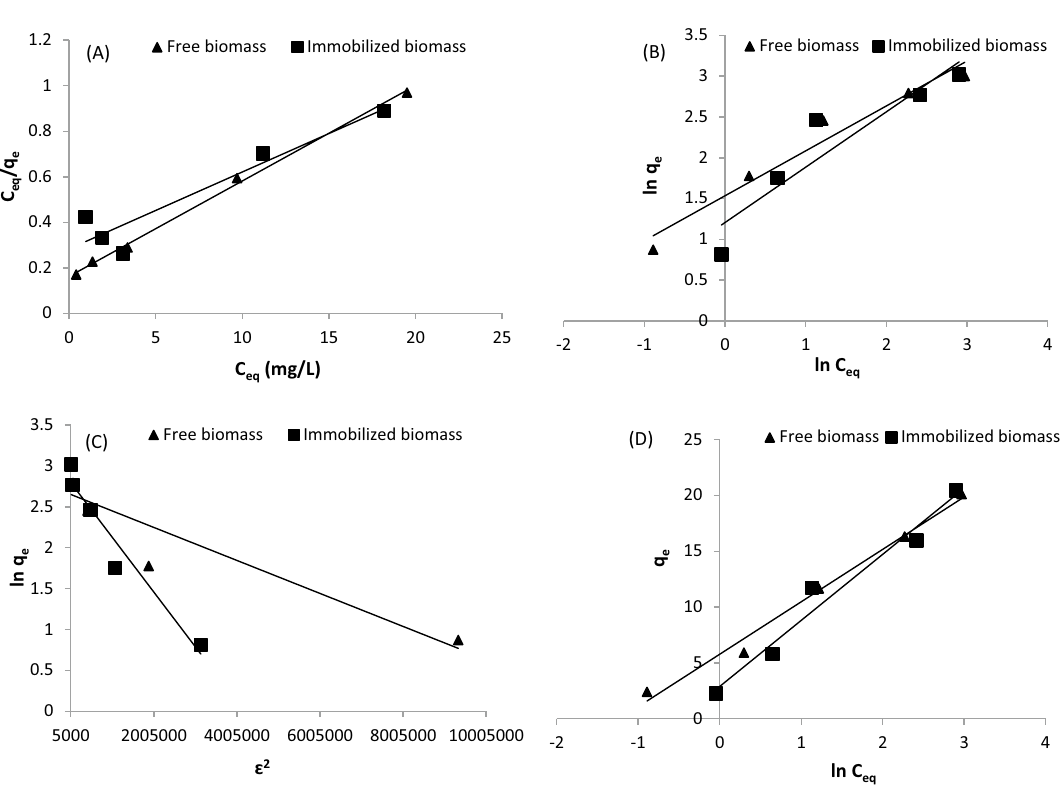
Figure 3. ( A ) Langmuir, ( B ) Freundlich, ( C ) Dubinin and Radushkevich, and ( D ) Temkin isotherm models of Cd 2+ ion biosorption by the freely suspended and Ca-alginate-immobilized T. ornata cells (biosorbent dose = 4 g/L; pH = 5.0; contact time = 90 min; temperature 25 °C; shaking at 170